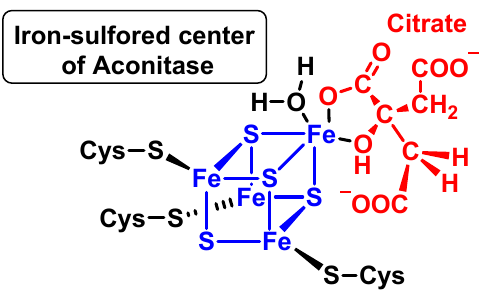
Figure 43. Iron–sulphur centre of aconitase and union with citrate and a water molecule.